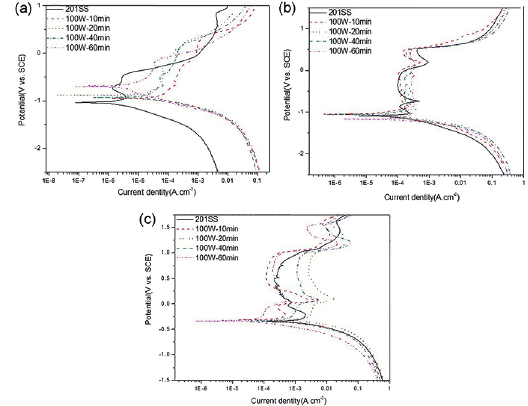
Figure 8: Hardness and Young's Modulus of the coatings at different time under 100 W plasma power. Figure 9: The potentiodynamic polarization curves of the coatings Table 2: The electrochemical parameters of the coatings in different corrosion mediums